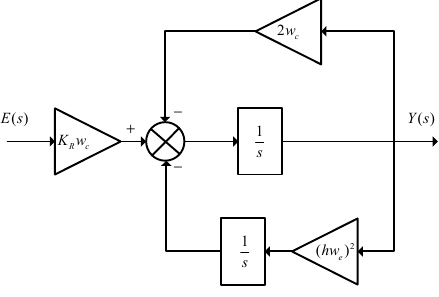
Figure 7. Structure of the improved resonant controller.